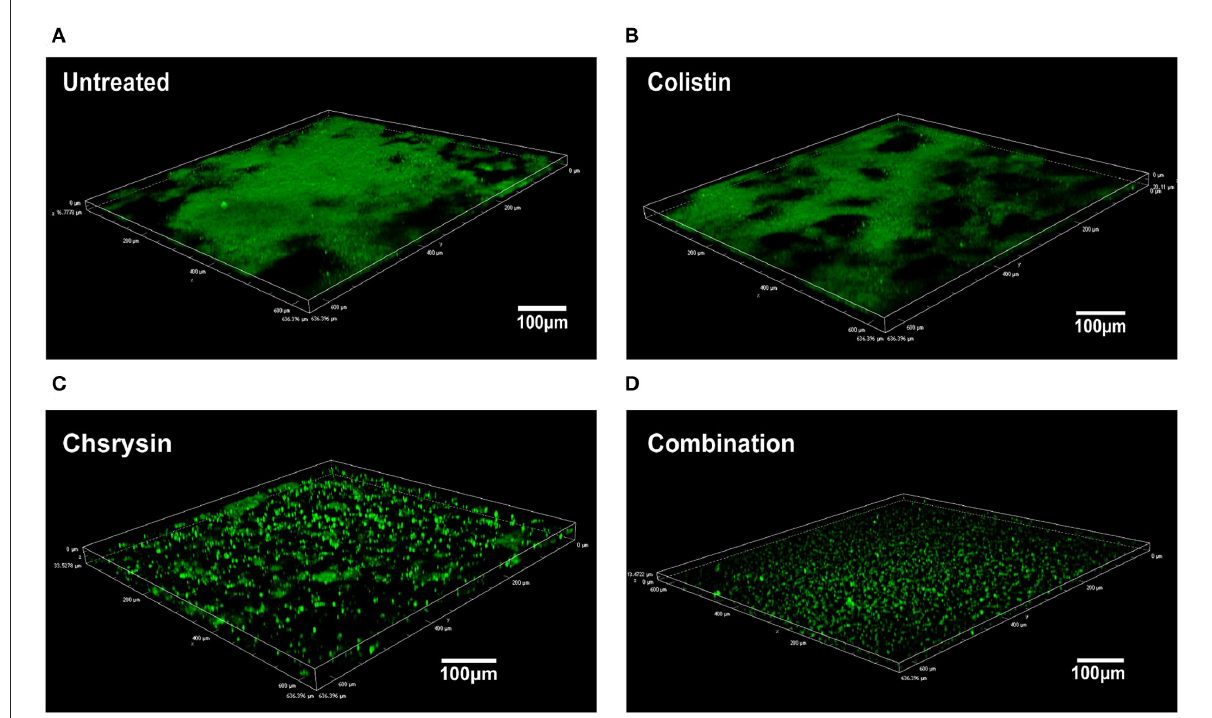
FIGURE6 Confocal Laser Scanning Microscopy (CLSM) of the effects of chrysin and colistin combination therapy on bacterial biofilm formation of COL-R A. baumannii BM2622. (A) Luria Bertani (LB) broth control at × 20 magnification. (B) Colistin alone at × 20 magnification. (C) Chrysin alone at × 20 magnification. (D) Chrysin/colistin combination at × 20